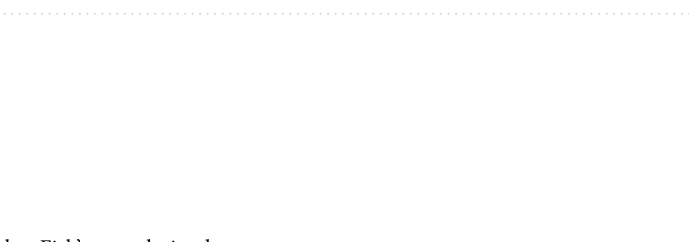
Table 1. Weights and biases of Robot Fish’s convolution